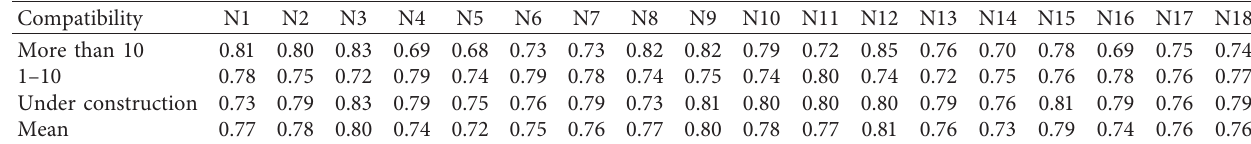
Table 7: The compatibility score of each BIM application area.